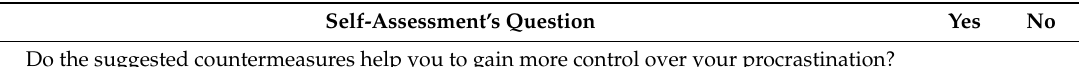
Table 6. Self-assessment’s